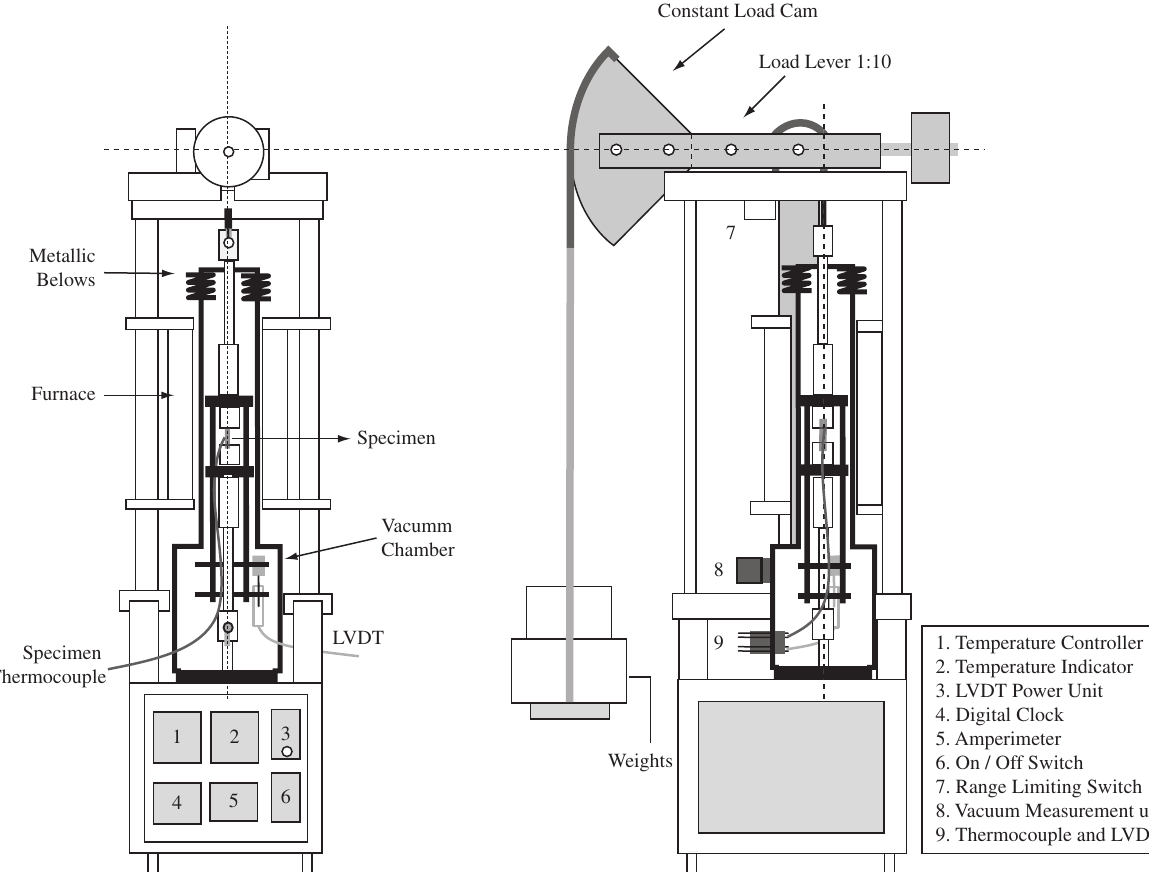
Figure 1. Schematic drawing of main components of creep machine and vacuum